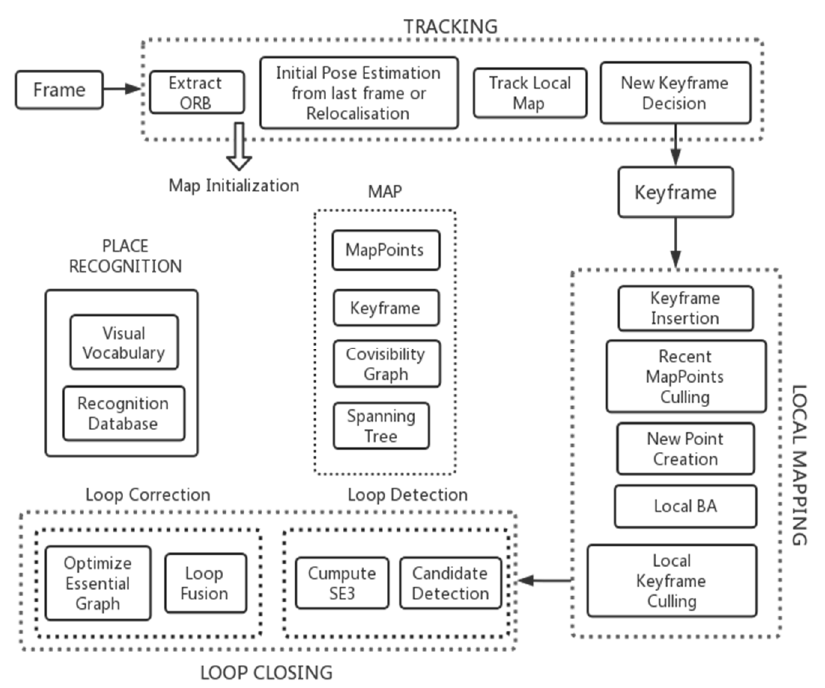
Figure 1. Block diagram of the ORB-SLAM2 algorithm.